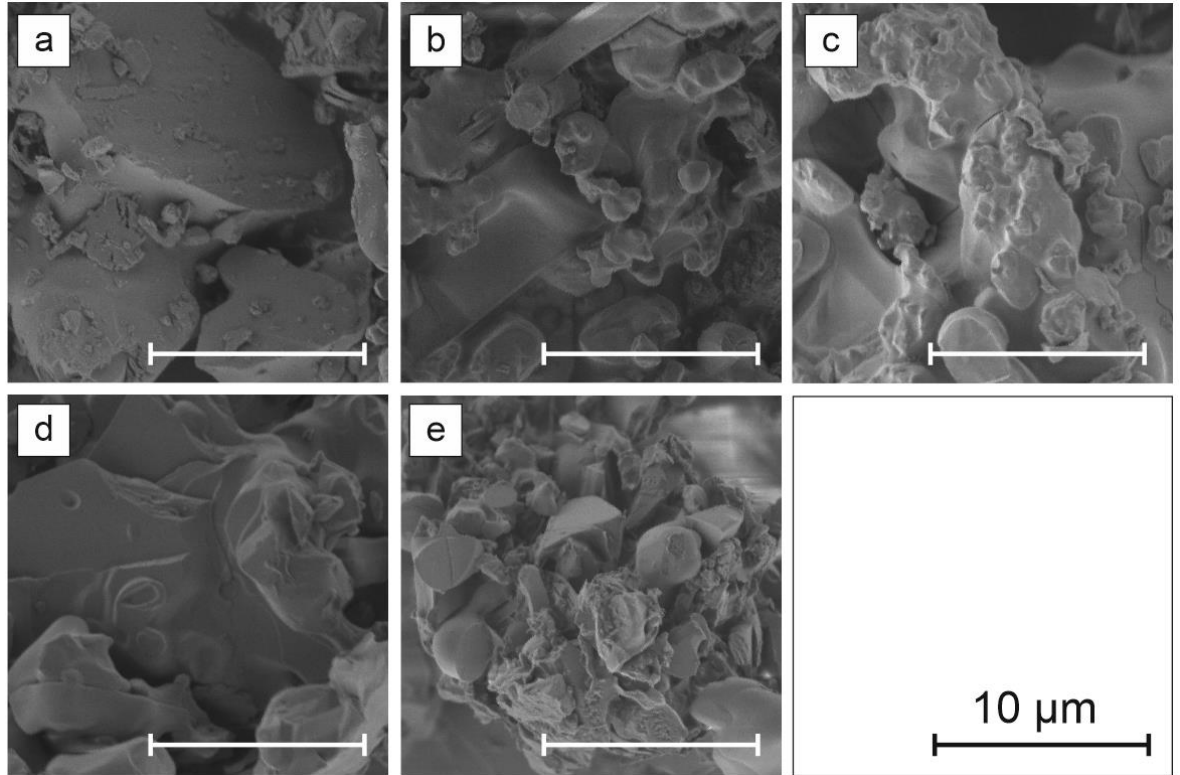
presented in Figure 6.